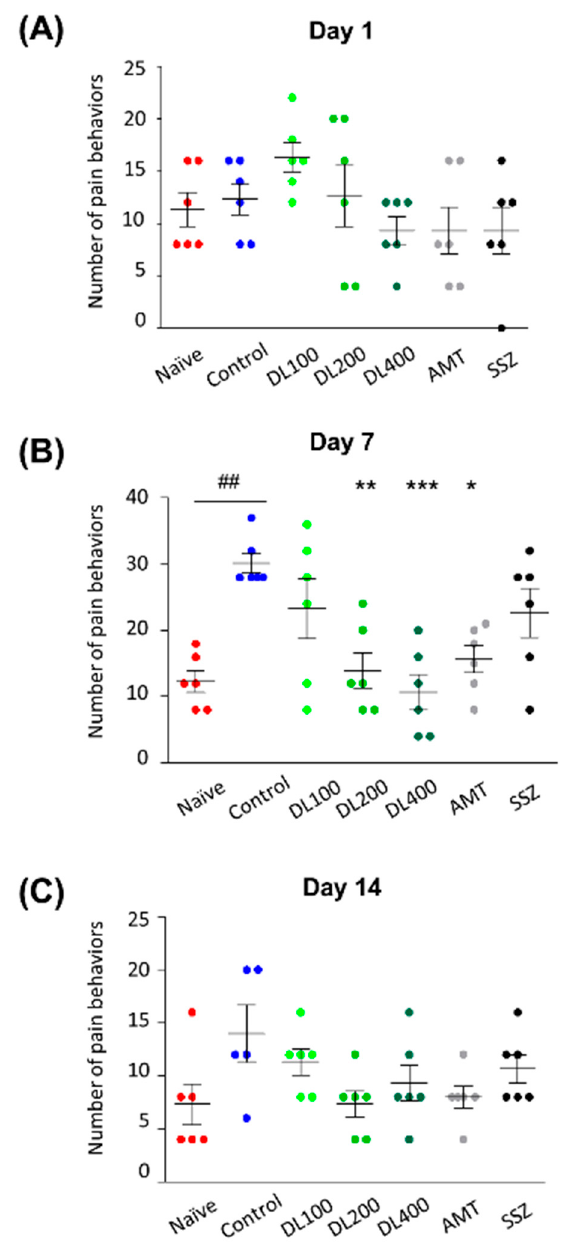
Figure 5. Effects of DL on visceral pain-related behaviors in zymosan-induced IBS mice. ( A ) Day 1, ( B ) day 7, and ( C ) day 14 according to the methods described in the Materials and Methods. Data are presented as a mean ± standard deviation ( n = 6, one-way ANOVA; ## p < 0.01 vs. naïve; * p < 0.05, ** p < 0.01, *** p < 0.001 vs. control). DL, D. lablab L. extracts; AMT, amitriptyline; SSZ, sulfasalazine.